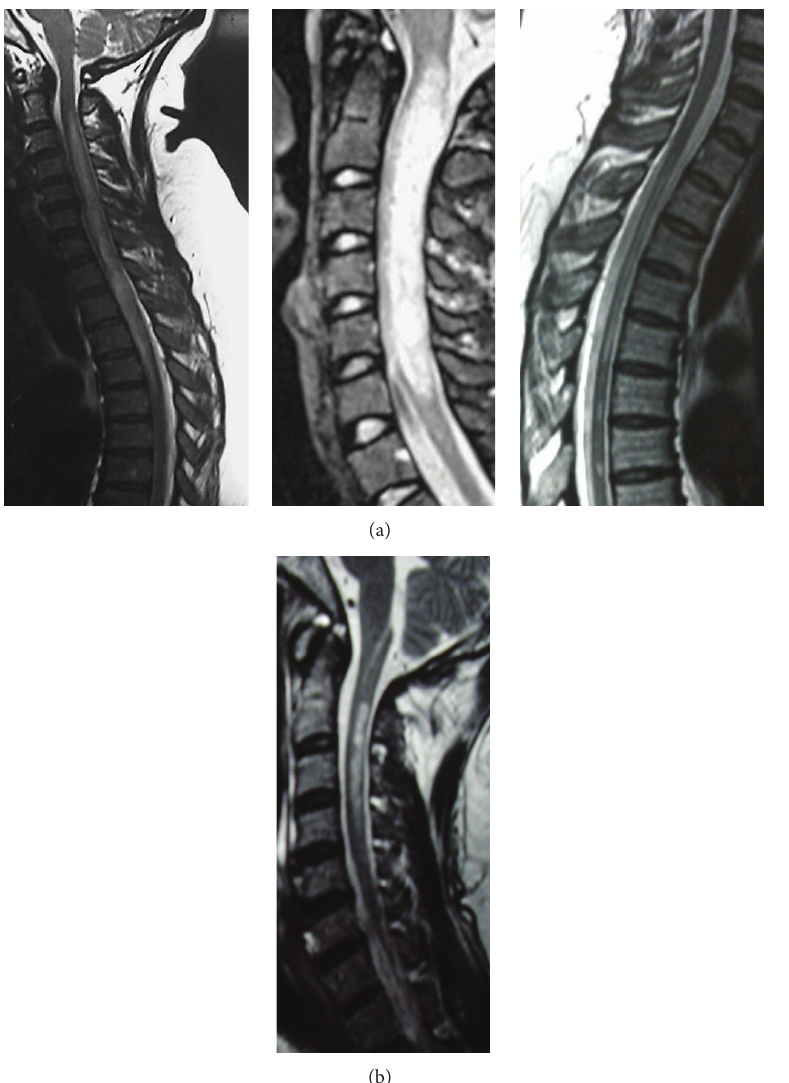
Figure1:T2WI(sagittalview)longitudinallyextensivecontiguoscordlesioninvolvingthecervicothoraciccord((a)extremerightandcenter) and longitudinally extensive linear cord lesion (a) extreme left. (b) Longitudinally linear and contigous cord